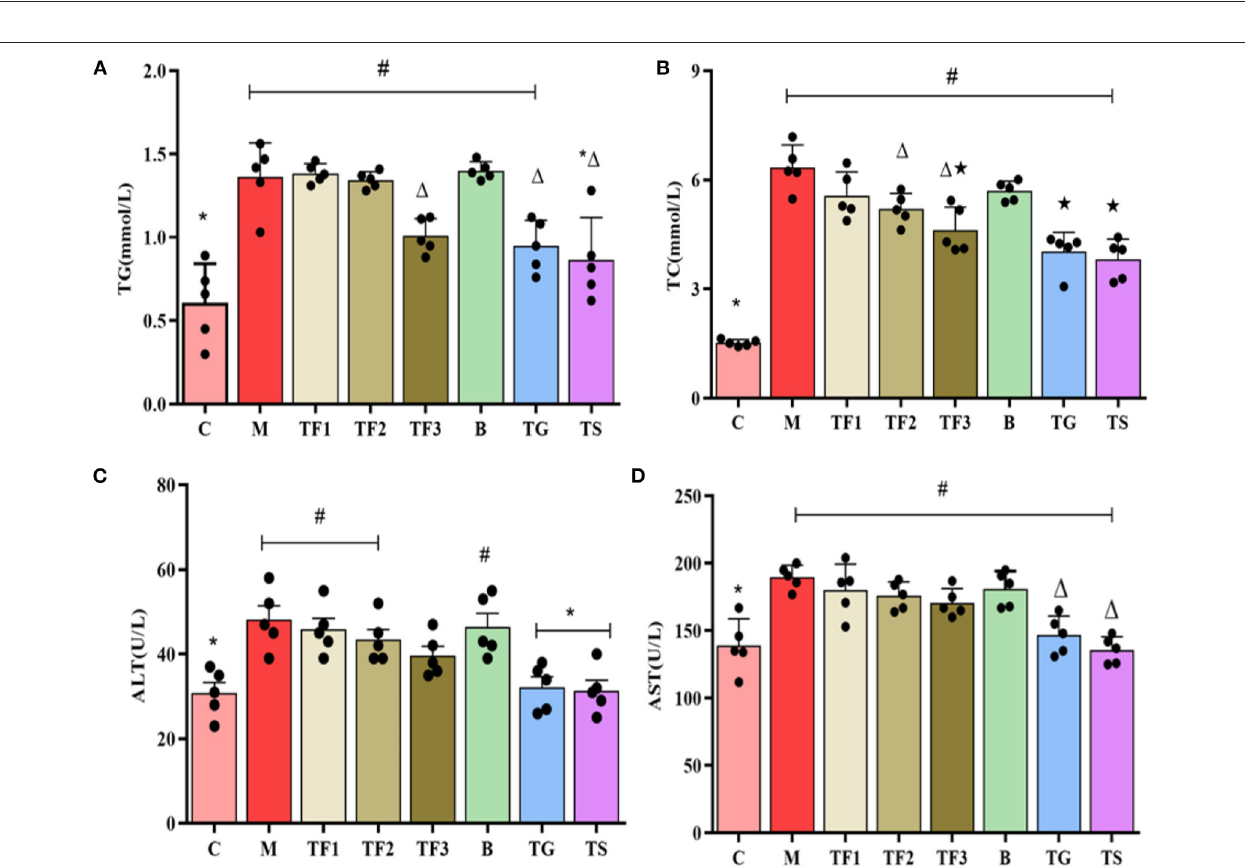
FIGURE 3 | The effects of various dosages of GABA-rich sprouted adzuki beans on blood lipid levels and liver and kidney function markers in mice with T2DM. The values represent the mean ± SEM ( n = 5); blood lipids: (A) TG, (B) TC; markers of liver function: (C) ALT, (D) AST. Values with different symbols differ substantially ( p < 0.05) from each